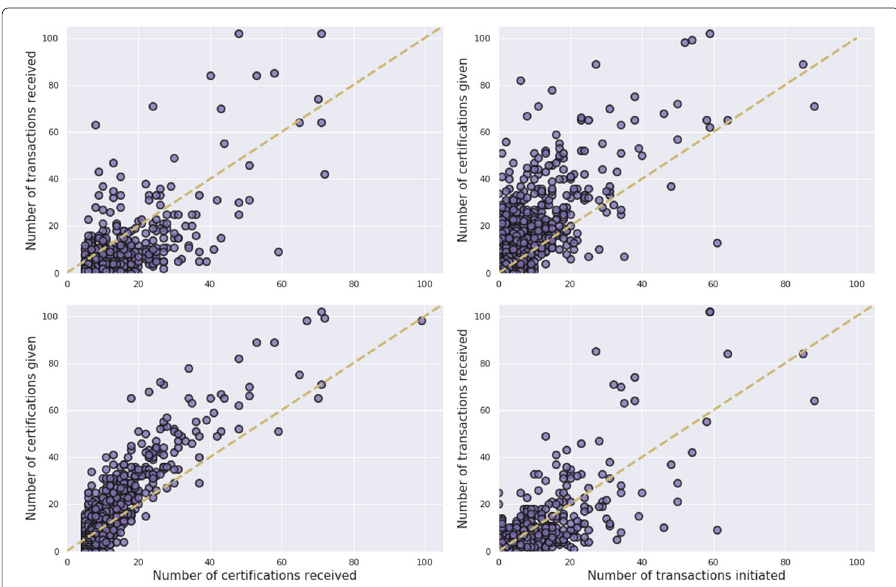
Fig. 6 Scatter plots of in-and-out degree correlations in G ( C ) and G ( T MM )